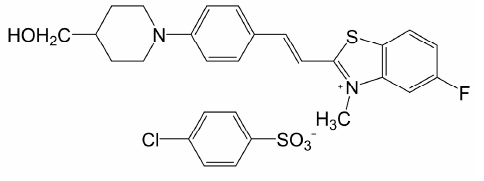
Figure 9. Chemical structure of benzothiazolium-based PFB-CBS. PMB-T crystal can form series-type cation-anion assembly through strong bidentate-like hydrogen bonds between the PMB cationic terminal HO- group and the sulfonate on T anions (Figure 10a,b) [46]. At the reference wavelength of 1800 nm, PMB-T exhibits a large SHG intensity comparable to DAST. The strongest hydrogen bonds were formed between the phe- nolic hydroxyl group on the cations and the sulfonate group on the anions (–O–H ···· − OS–), with a distance of 1.902 Å (Figure 10c) for HMB-TMS [47]. The molecular order angle of the HMB-TMS crystal is close to zero, showing a large SHG intensity similar to that of DAST at 1250 nm. Two kinds of strong hydrogen bonds are formed between the phenolic group (-OH) of the HDB-T cation and the sulfonate group (-SO 3 − ) on the anion (Figure 10d). The hydrogen bond distances between H atoms in hydroxyl groups and O atoms in sulfonic groups are 1.884 and 2.044 Å for the two different oriented HDB cations, respectively. HDB cations stack with each other at an angle of 16.46 ◦ through face-to-face π - π stacking interactions, and each layer is in the same direction at an angle of 66.91 ◦ along the c -axis in HDB-T (Figure 10d) and with an X-shaped arrangement. In this way, the microscopic nonlinearity can be effectively accumulated, and the SHG intensity of HDB-T reaches 1.5 times that of OH1 at 2090 nm